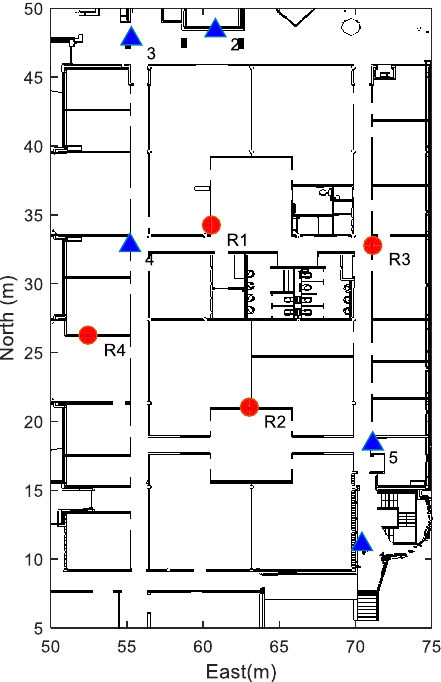
Figure 15. The setup of the experiment scene (Blue Triangles: Anchors, Red Circles:MS).